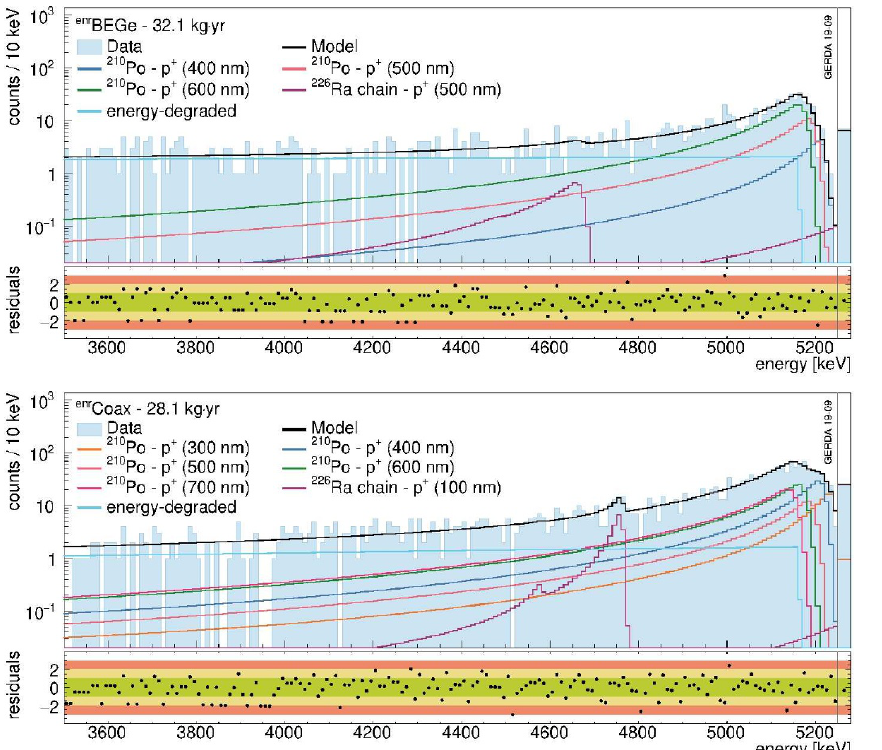
Figure 9. Fit results of the (cid:11) events background analysis for M1-enrBEGe (top) and M1-enrCoax (bottom). The last bin contains all events above 5250